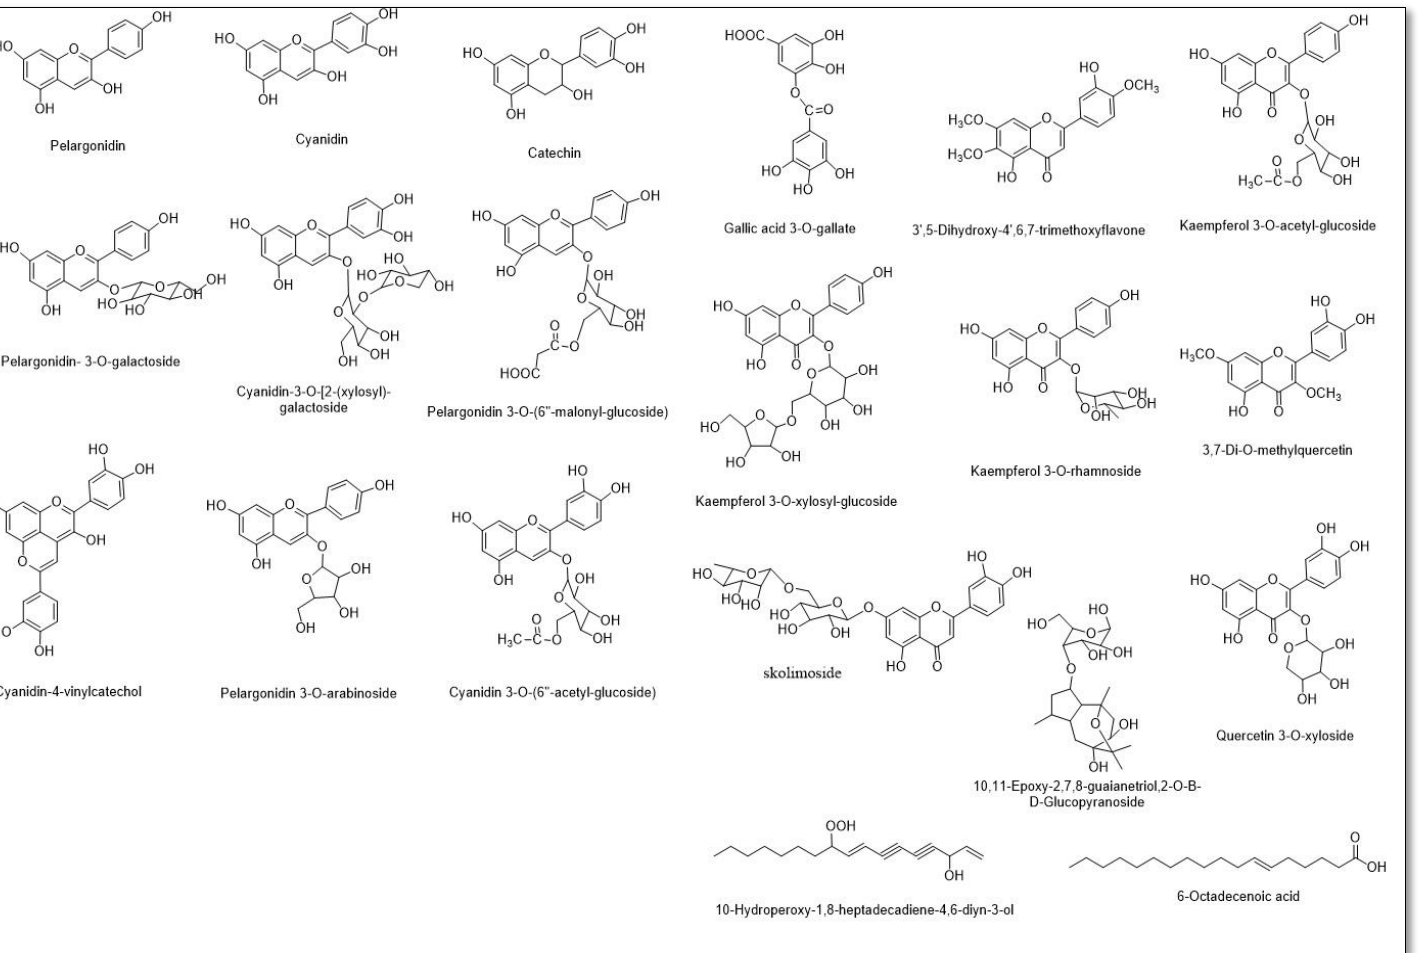
Figure 2. Formula of the compounds resulting from LC–MS metabolomic analysis of the red carrot methanolic extract.